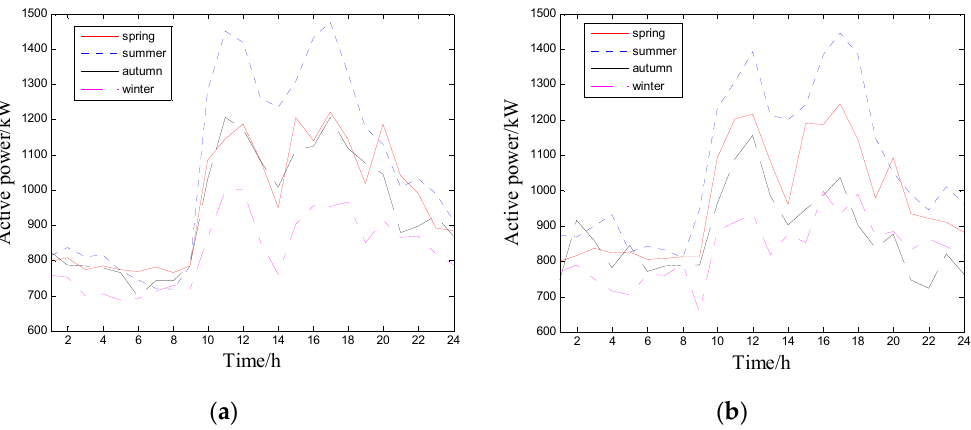
Figure 1. The typical daily load curves of different scenarios in a certain region: ( a ) weekdays in four seasons; and ( b ) weekends in four seasons.